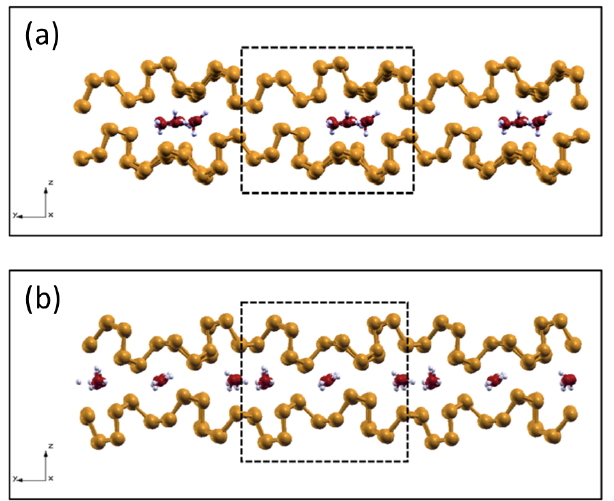
Figure 8. Side view of the phosphorene interfaces covered by 25% ( a ) and 50% ( b ) of water molecules during 8.7 ps and 11.6 ps of sliding dynamics under extreme pressure